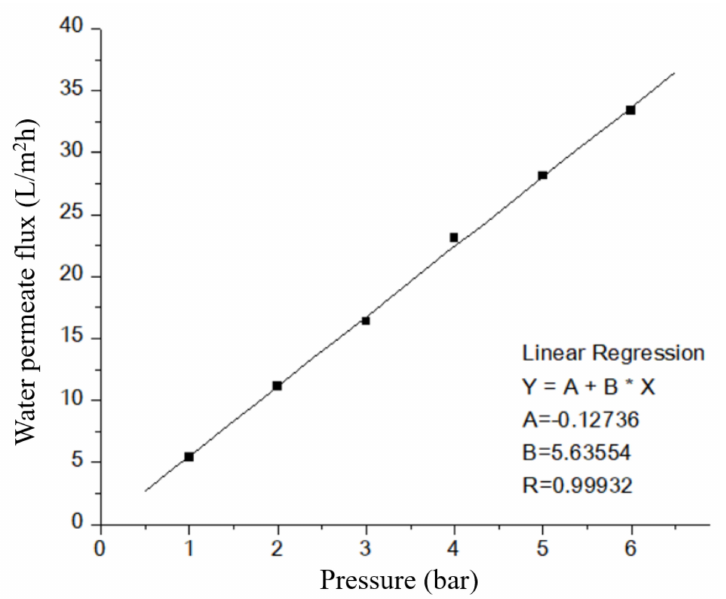
Figure 9. Water permeate flux (L/m 2 h) versus pressure of TiO 2 /GO-Al 2 O 3 HF NF membrane. The line represents the linear fit to the experimental data.